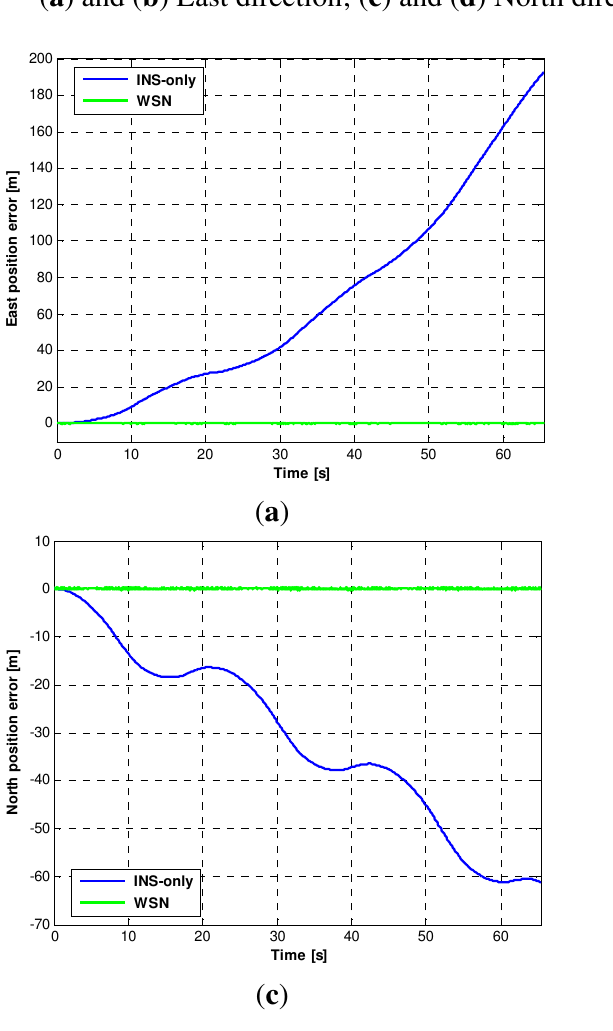
( a ) and ( b ) East direction; ( c ) and ( d ) North direction.